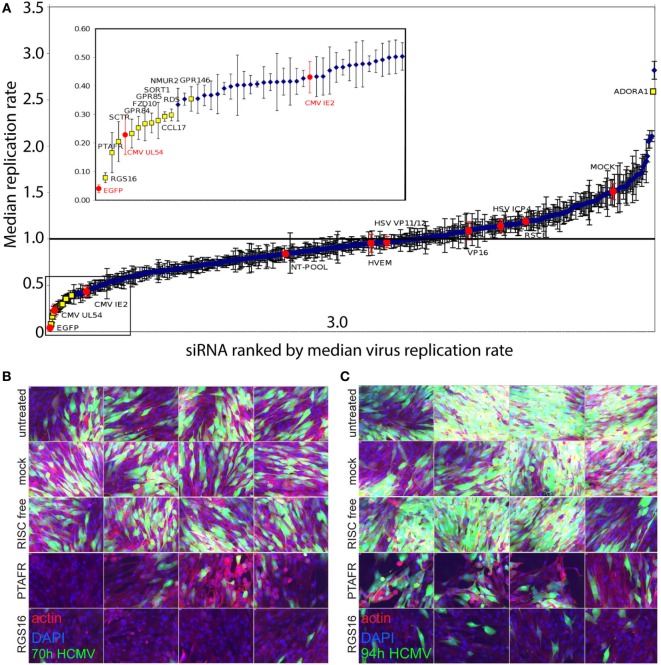
Loss-of-function screen of GPCRs using an HCMV real time replication assay. MRC-5 fibroblasts were reverse-transfected (n = 3 with two technical replicates) with siRNA from the Human GPCR SMARTpool library followed by infection with AD169-GFP HCMV. Untreated controls cells, mock treated cells (reagent only), siRNA targeting eGFP, HSV ICP5, HSV VP11/12, HSV VP16, HVEM, Non-Targeting Pool, and cells treated with RISC-free siRNA served as negative controls. Cells treated with siRNA, against IE2 and UL54 served as positive controls. All cells were infected with AD169-GFP HCMV post-siRNA treatment and growth monitored using eGFP detection. Distribution profile of (plate-by-plate negative control-normalized) virus replication slopes across the entire screen [median ± median absolute deviation (MAD)], indicating controls and potential hits of interest (A). High-content images (PerkinElmer OPERA) of siRNA-treated and AD169-GFP-infected fibroblasts at two different time points (B,C). Knockdown of PTAFR or RGS16 was followed by infection with AD169-GFP HCMV for 70 h (B) and 94 h (C). Untreated controls cells, mock treated cells (reagent only), and cells treated with RISC-free siRNA, all infected with AD169-GFP HCMV, served as negative controls. Nuclei were stained with 4′,6-diamidino-2-phenylindole (DAPI) and actin was visualized with AlexaFluor-647-Phalloidin.